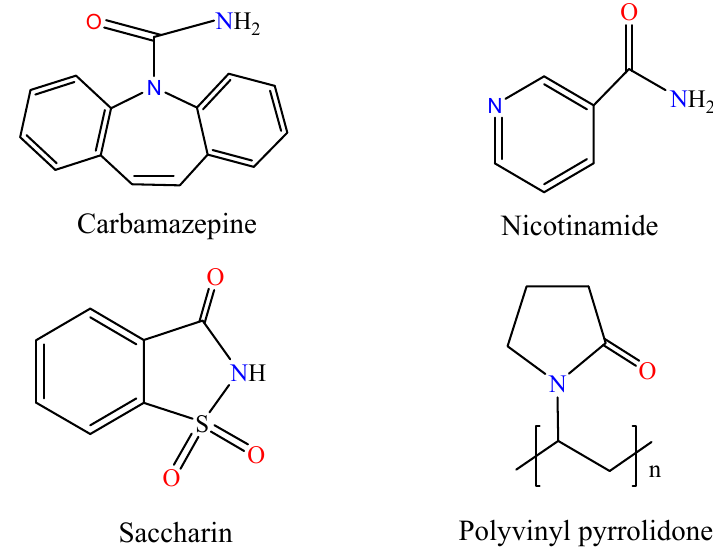
Figure 1. Molecular structure of carbamazepine, nicotinamide, saccharin, and polyvinyl pyrrolidone.